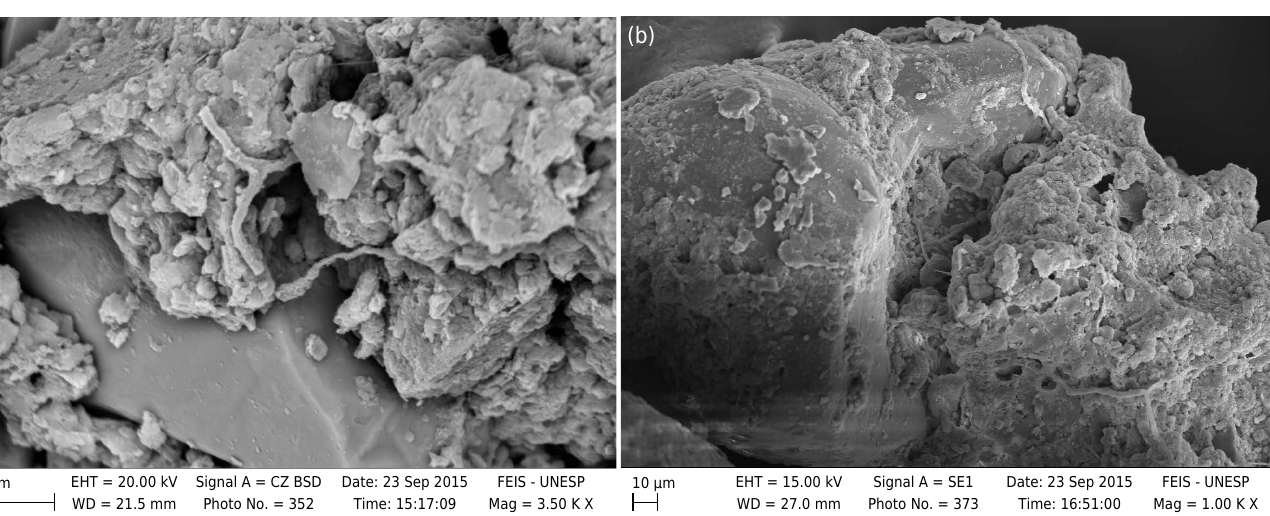
Figure 1. Images obtained by scanning electron microscopy (SEM) of the aggregates with a diameter from 0.50 to 1.00 mm in the 0.00-0.05 m layer under the land use systems (preserved Cerrado - CER, 15-year-old Eucalyptus - EU15). (a) CER 0.50-1.00 mm; (b) EU15 0.50-1.00